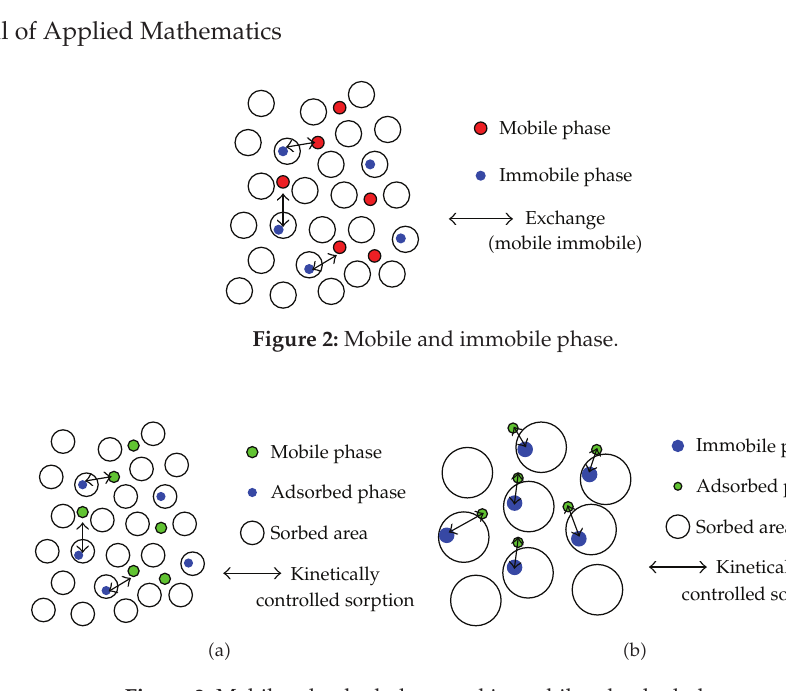
Figure 3: Mobile-adsorbed phase and immobile-adsorbed